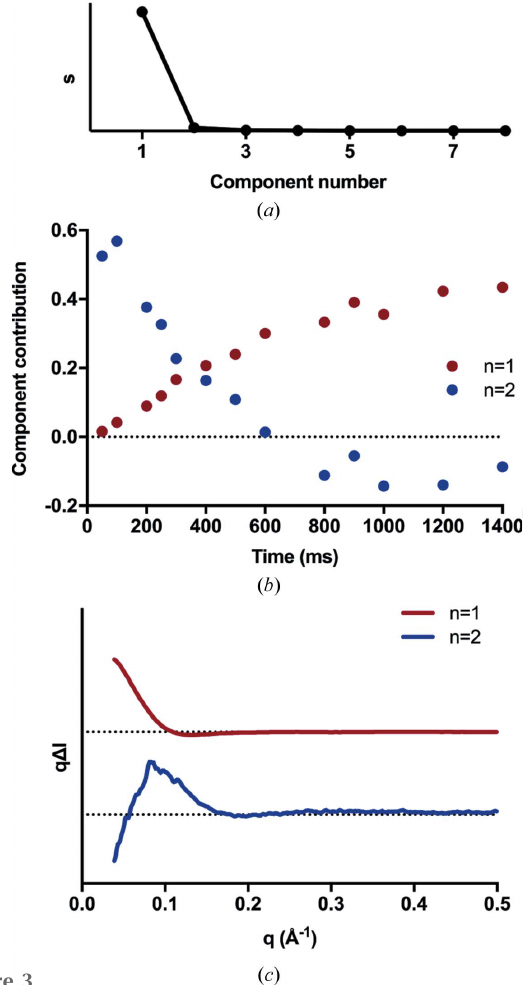
Figure 3 Single-value decomposition analysis of the TR-XSS data reveals the presence of two components. ( a ) Singular values (from the diagonal of matrix s) plotted on a linear scale. ( b ) Singular (V T ) matrix showing the relative amplitudes of the eigenvectors (component 1 and 2 in red and blue, respectively) versus time. ( c ) Singular (U) matrix showing the eigenvectors for the two major